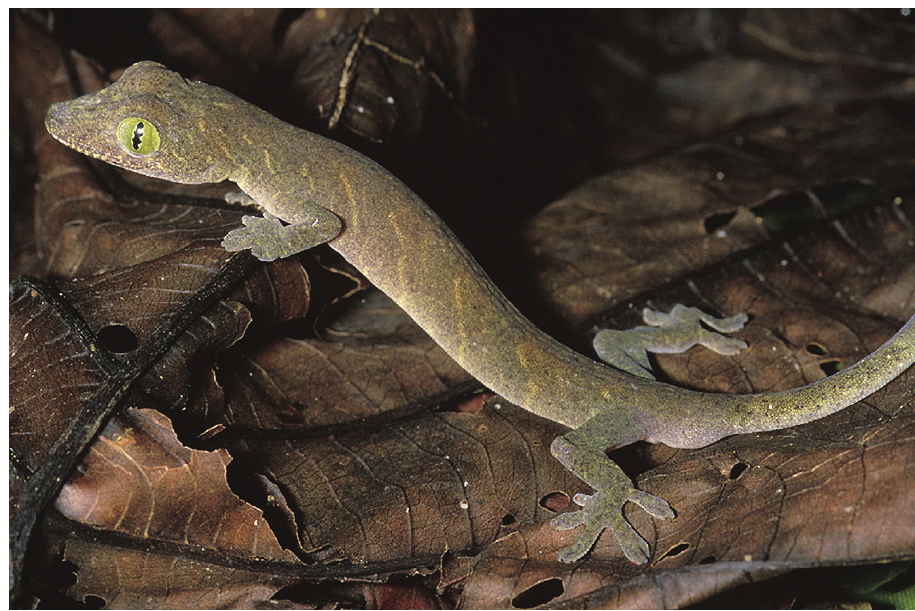
Figure 50. Pseudogekko pungkaypinit has been collected in Mt. Lumot, Municipality of Gingoog, Misamis Oriental Province. Photo: RMB (from the Municipality of Baybay, Leyte Island; KU